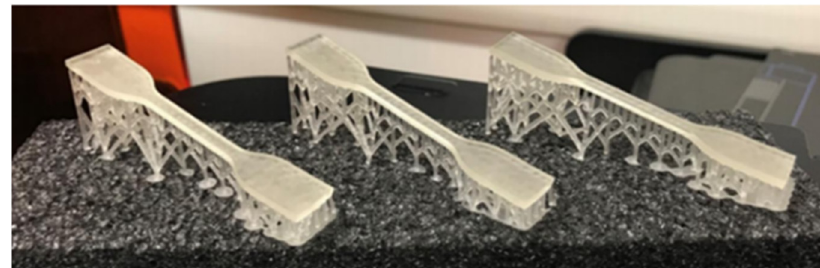
Figure 1. Three-dimensional printed 5A specimens (Form 2, Standard Clear Resin). The guideline specifications recommended by the Formlabs website were followed. The parameters are reported in Table 1. Table 1. FormCure settings [4].